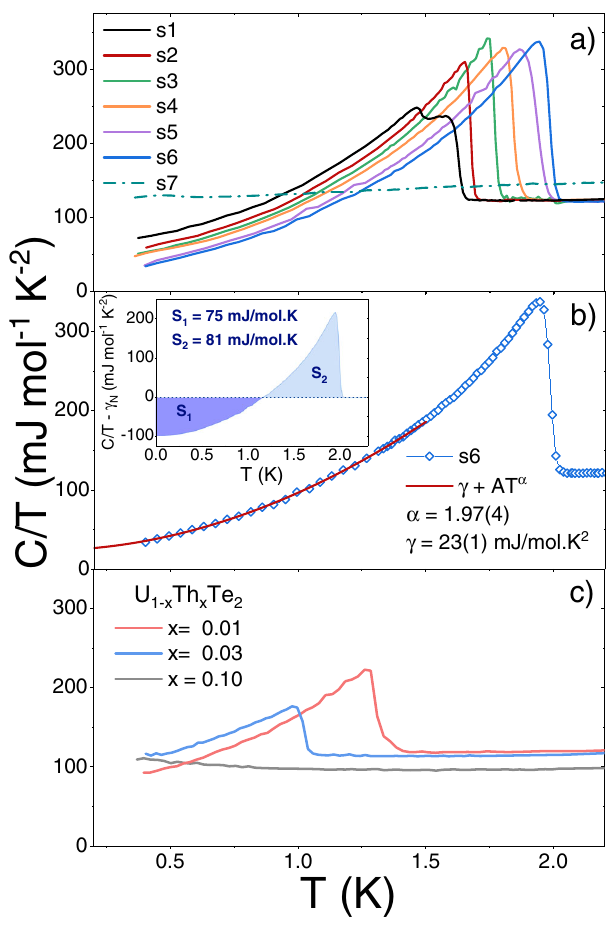
Fig. 1 Speci fi c heat of UTe 2 single crystals. a C / T as a function of temperature for seven representative samples. b C / T as a function of temperature for sample s6. The solid line is a power-law fi t below 1.5 K. Inset shows the entropy balance in a C / T − γ N vsT plot. c C / T as a function of temperature for Th-doped UTe 2 single